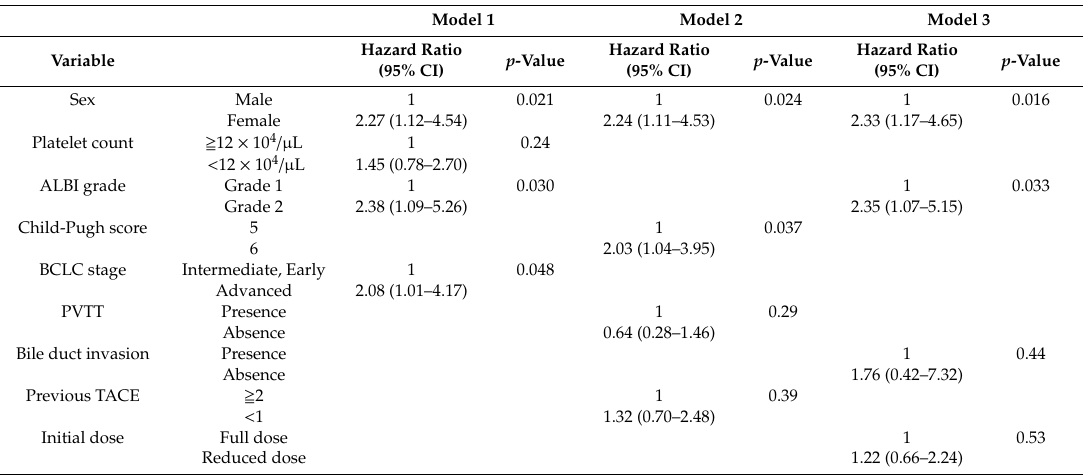
Table 4. Results of a multivariate analysis of factors associated with the time to progression to Child-Pugh class B ( n = 110).